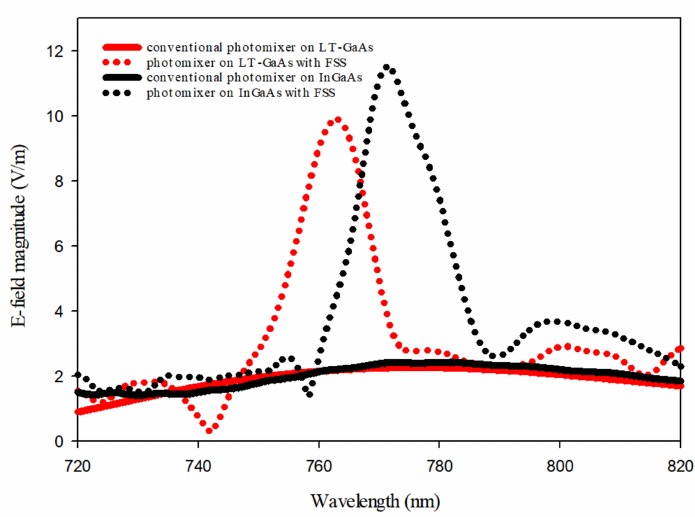
Figure 5. Optical E-field magnitude between the central electrodes of a photomixer on the surfaces of LT-GaAs and I GaAs photoconductive layers.